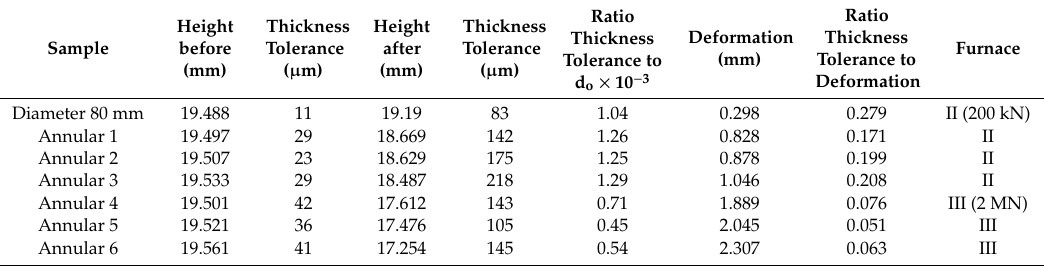
Figure 1. Schematic representation of the height measuring points of the samples. Left : Circular sample. Right : Annular sample. Table 5. Thickness tolerance before and after di ff usion bonding and deformation for samples made of 10 layers.